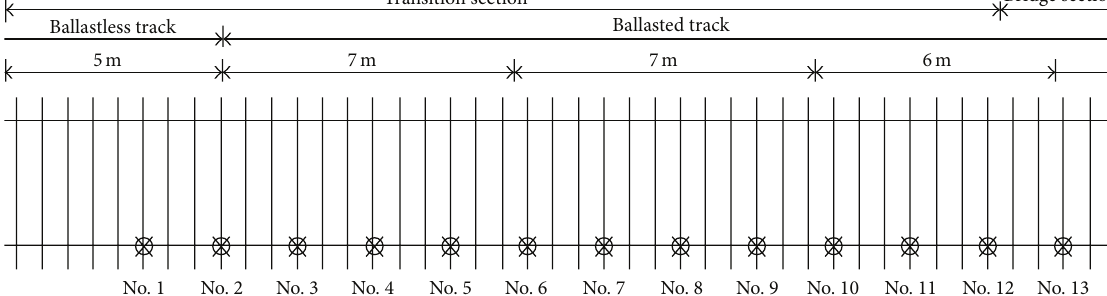
Figure 4: Layout of the locations of the dial indicators (accelerometers).